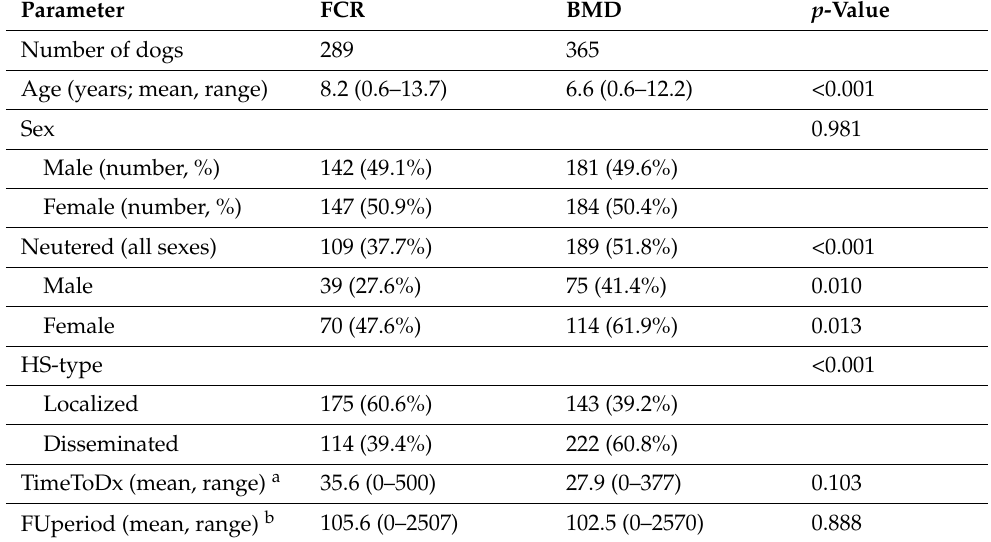
Table 1. Comparison of patient descriptives of FCR and BMD with